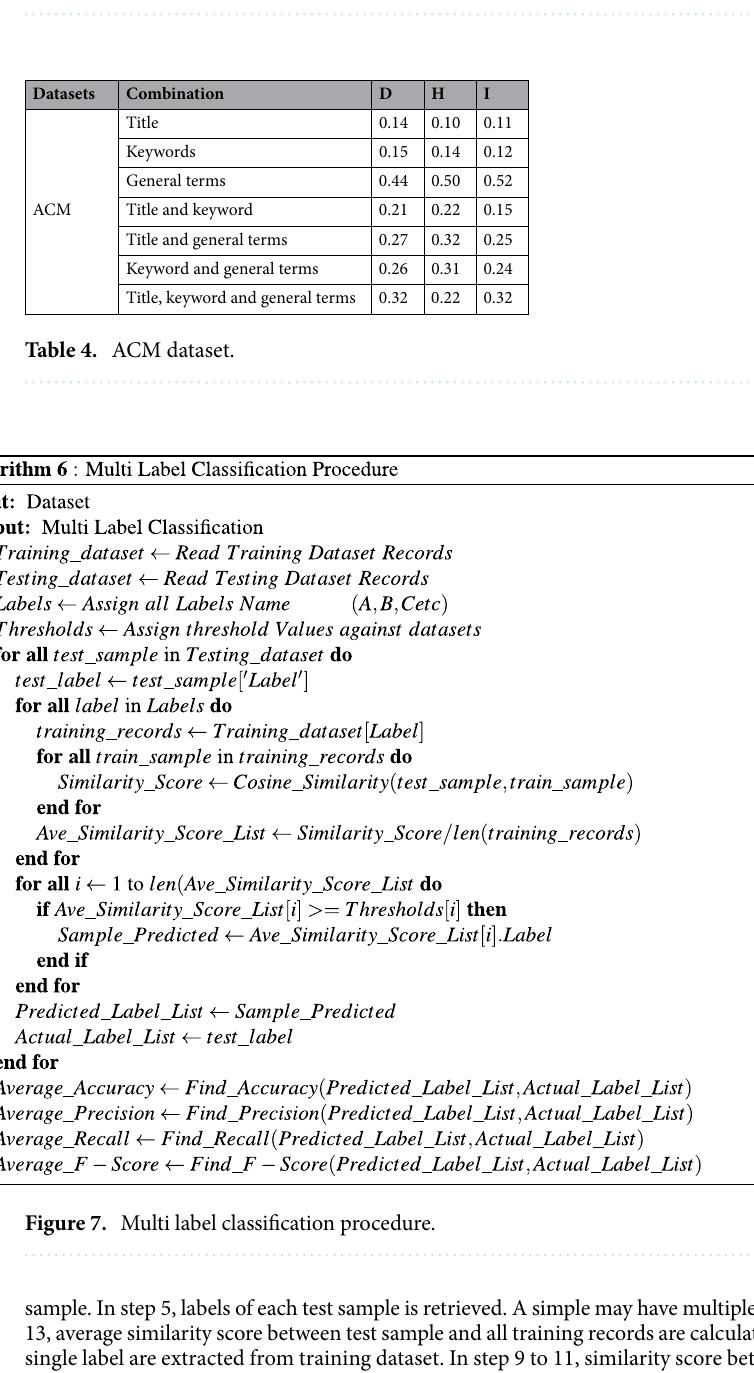
Table 3. JUCS dataset.